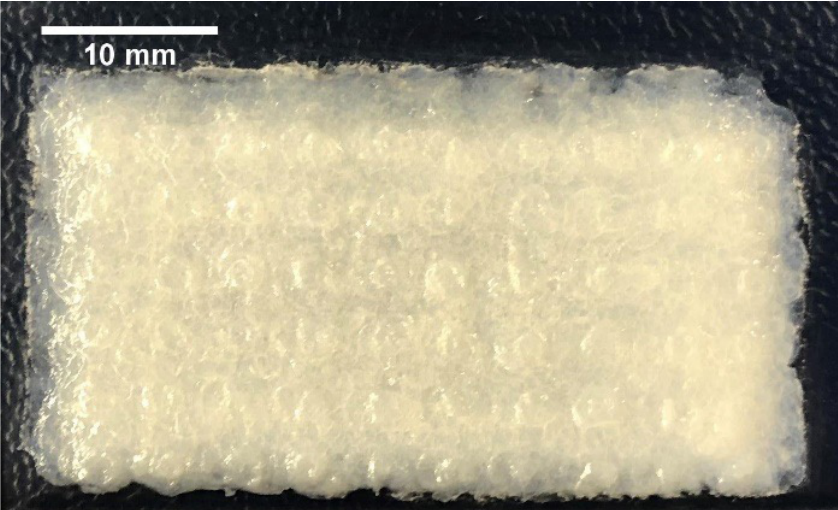
Figure 3. Exemplary result of a thin-layer packing. Dimensions: length = 46 mm (left to right); width = 23 mm, and a height 1 mm; average porosity